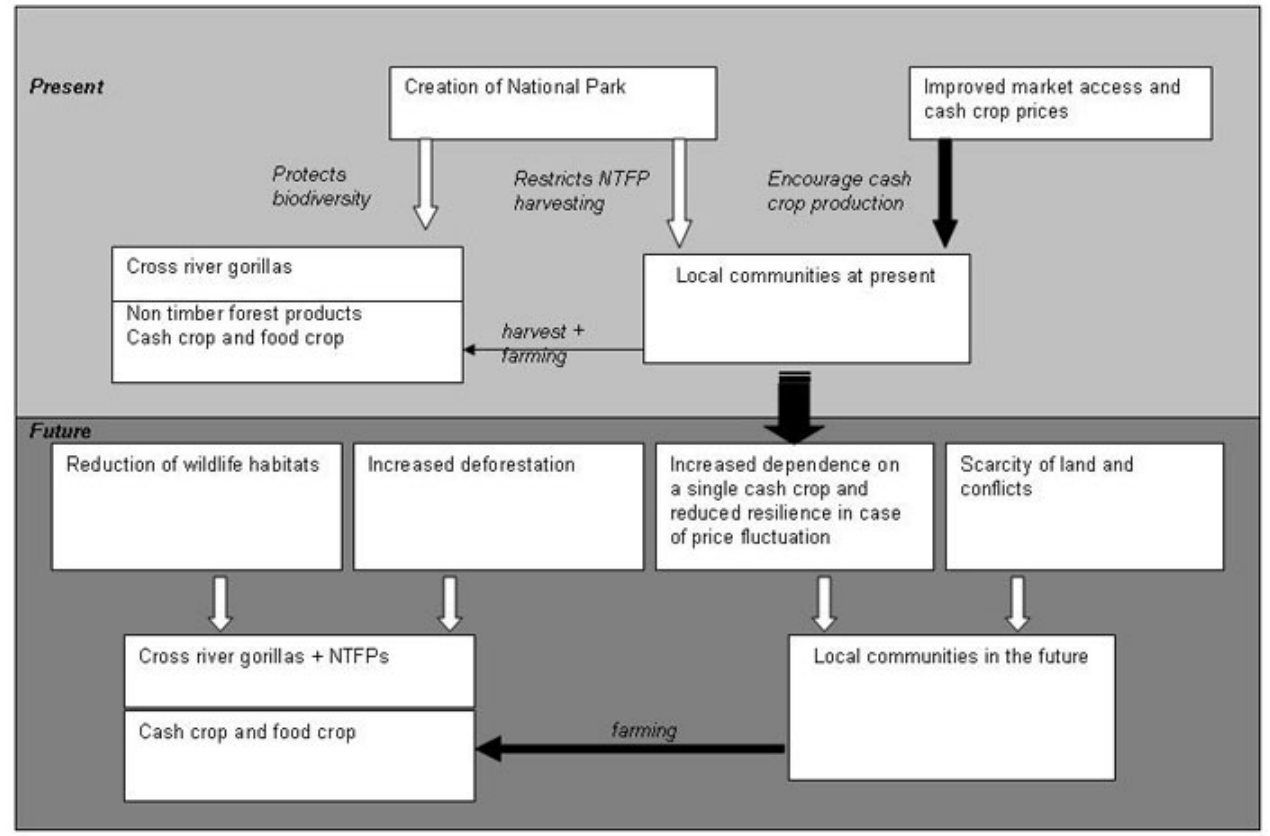
Fig. 2. Mapping risks and opportunities in local communities living around or inside Takamanda National